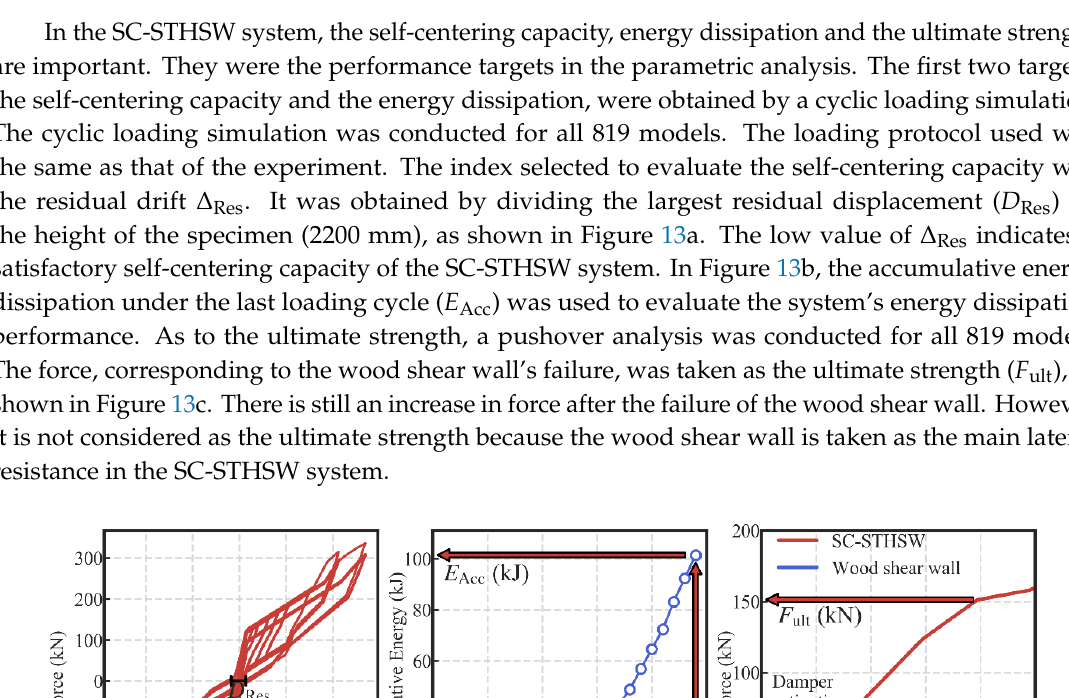
Table 4. Parameters selected for the analysis.